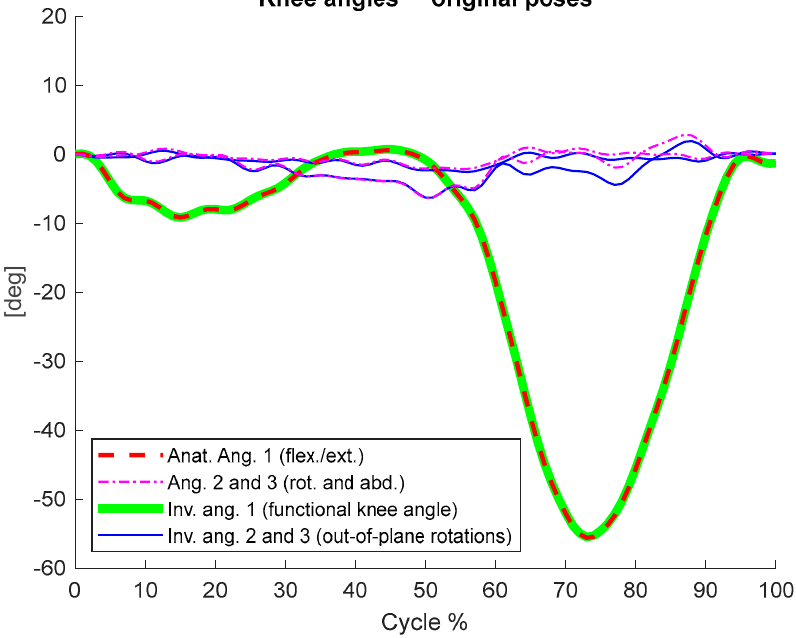
Figure 1. The anatomical angles based on the measured poses and the respective invariant angles calculated according to the proposed procedure.